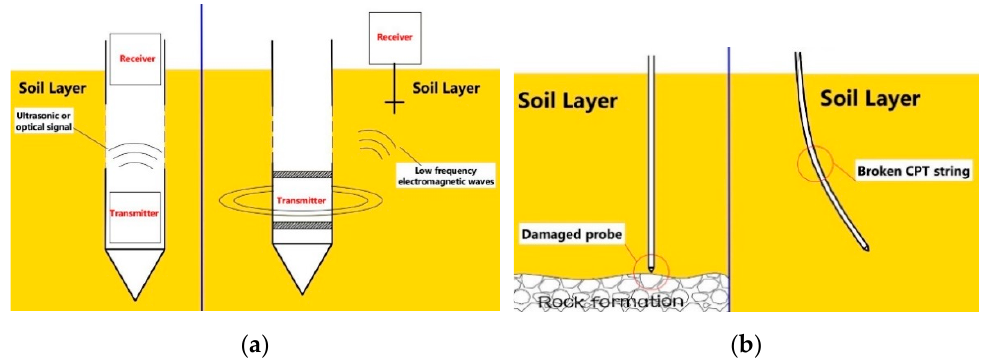
Figure 2. Some new methods and special cases: ( a ) optical communication and electromagnetic wave communication; ( b ) the probe is squeezed by the rock or the CPT string is bent.